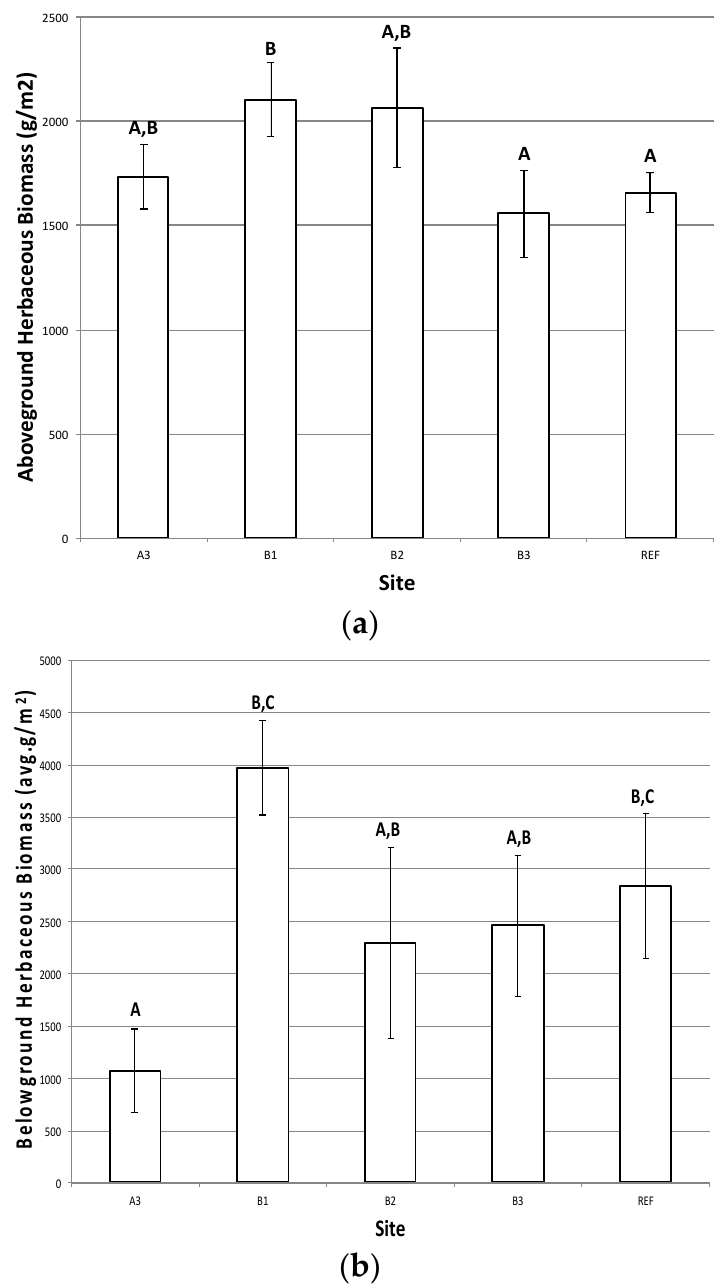
Figure 3. Aboveground ( a ); and belowground ( b ) herbaceous biomass at study sites in the CWU. Different letters indicate a significant difference α = 0.05. Error bars represent standard error of the mean.